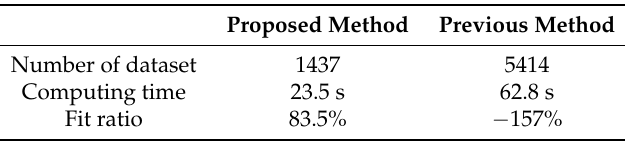
Table 5. The comparison of some